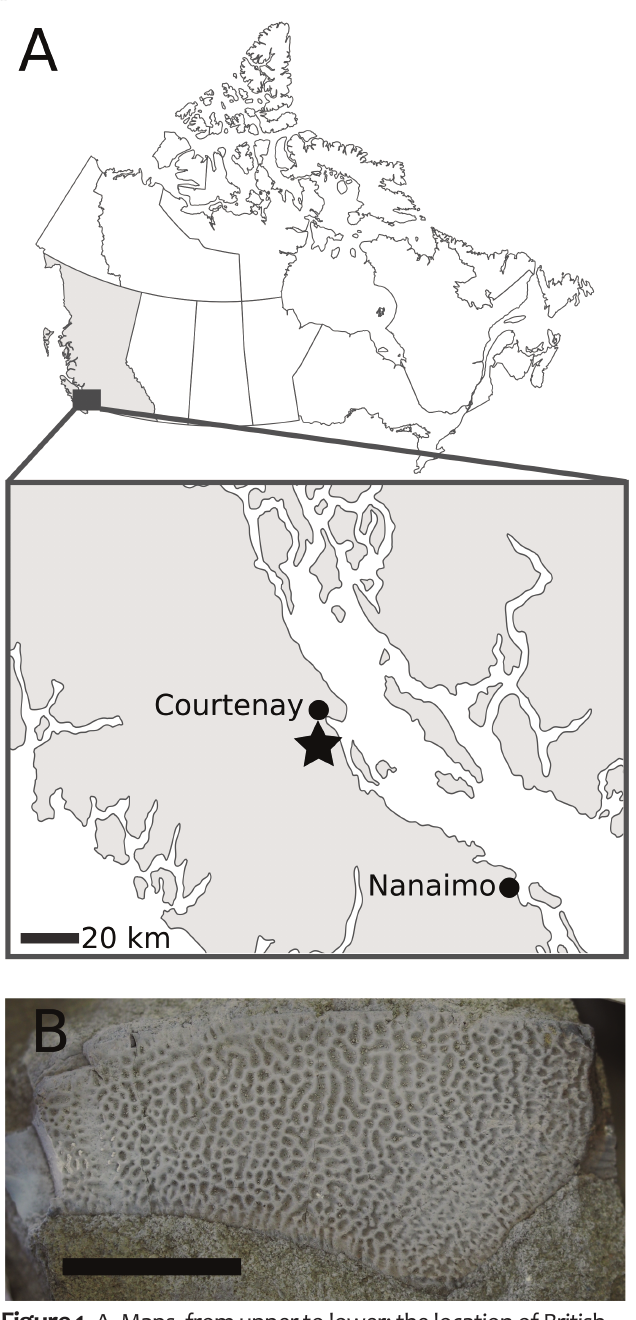
Figure 1. A, Maps, from upper to lower: the location of British Columbia (grey shading) within Canada, with the location of the regional map indicated by the grey rectangle; a regional map showing the location of the fossil site in Cumberland, Vancouver Island, British Columbia. Location of RBCM EH2004.012.1353 is denoted with a star. B, RBCM EH2004.012.1353, isolated costal of a trionychid. Scale bar equals 2